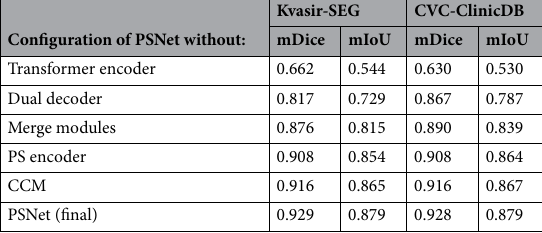
Table 5. Ablation